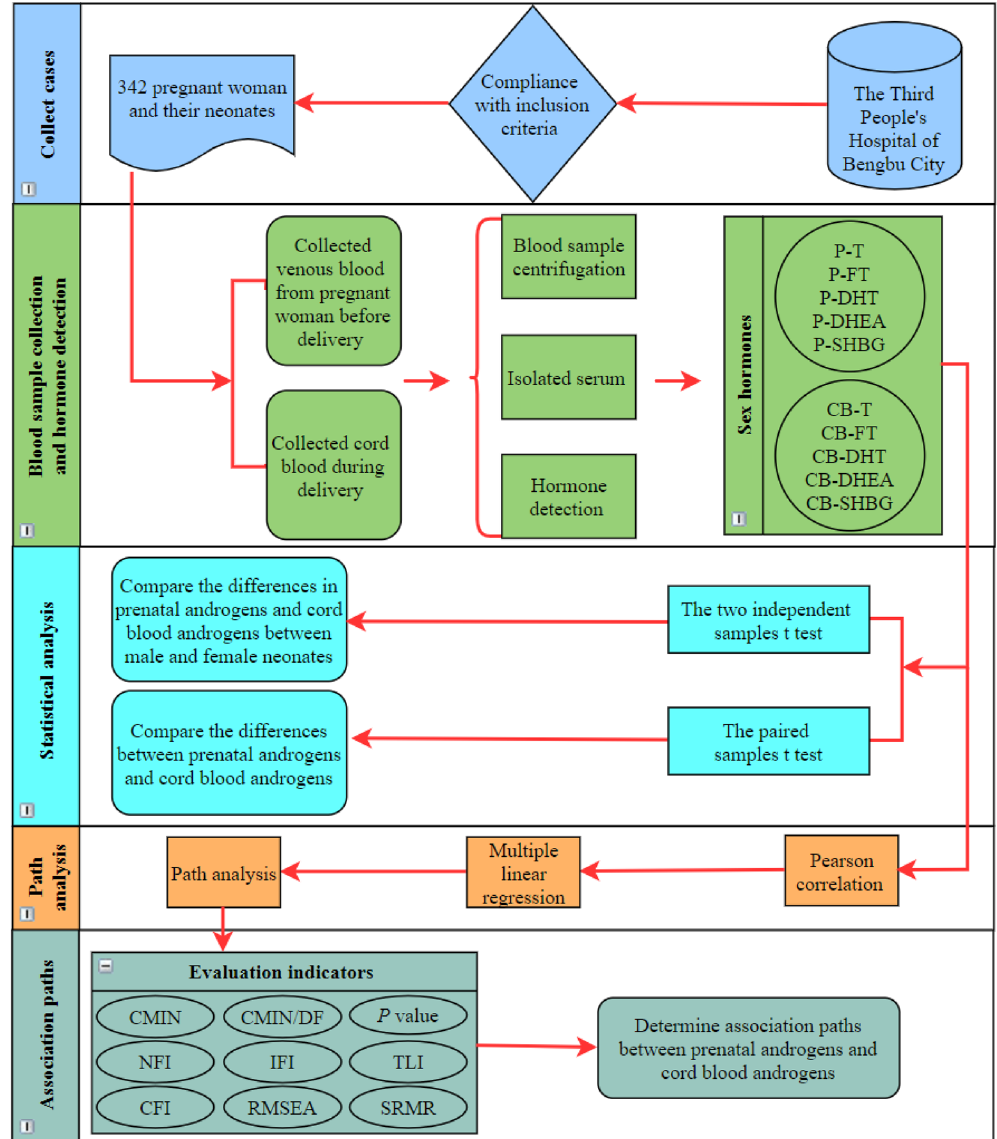
binding globulin, CB-T cord blood testosterone, CB-FT cord blood free testosterone, CB-DHT cord blood dihydrotestosterone, CB-DHEA cord blood dehydroepiandrosterone, CB-SHBG cord blood sex hormone binding globulin, CMIN Chi-square, CMIN/DF Chi-square/degree of freedom, NFI normed fit index, IFI incremental fit index, TLI Tucker–Lewis index, CFI comparative fit index, RMSEA Root Mean Square Error of Approximation, SRMR Standardized Root Mean